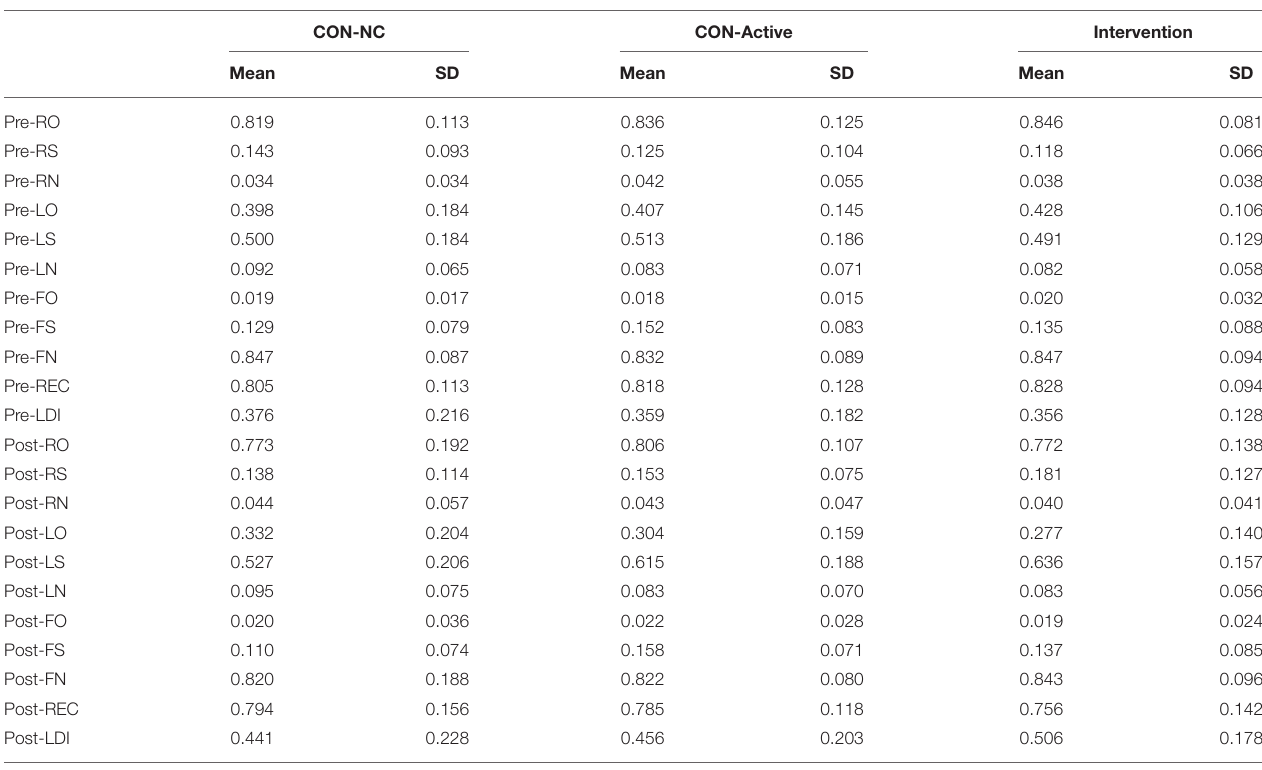
TABLE 1 | Pre- and post- response rates, LDI and REC scores. CON-NC CON-Active Intervention